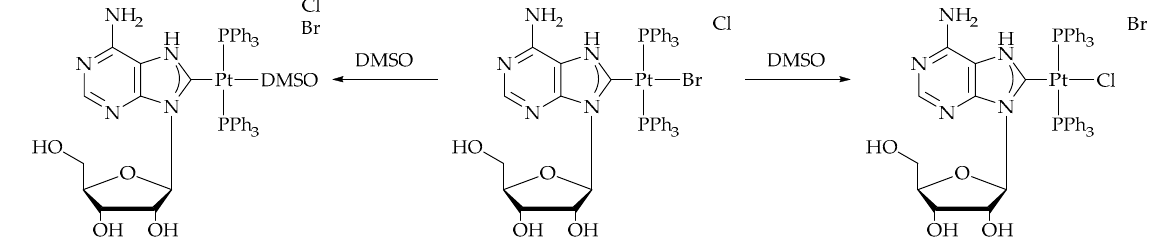
Figure 4. Evolution of the 1 H NMR spectrum of complex 5 in DMSO- d 6 at room temperature during different times. The mentioned percentages were calculated considering the signals for both NH and H-1 (cid:48) , which were in accordance.